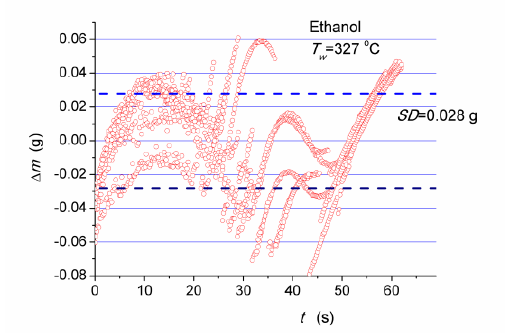
Fig. 4. Residuals of measurement points with respect to the mean line.